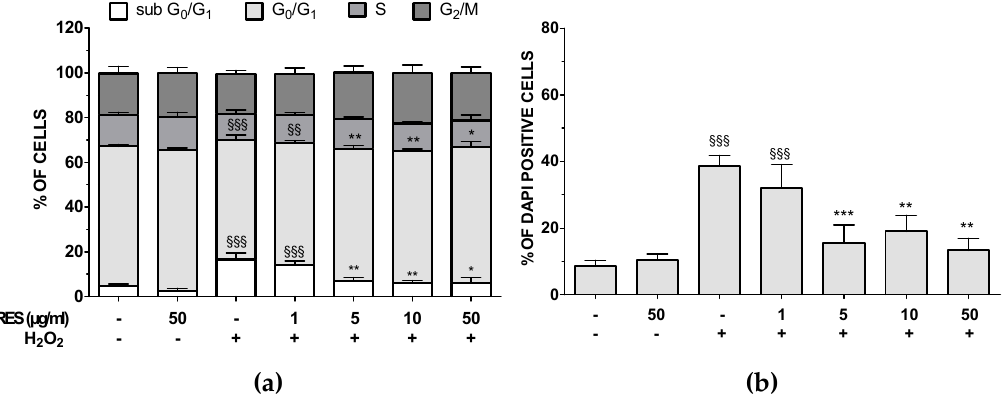
Figure 3. Effects of PRES on OS-induced changes in SH-SY5Y cell cycle and DNA condensation. Cells were treated with PRES (1–50 µg/mL) for 1 h before OS and for the following 24 h. OS was reproduced by using H 2 O 2 (25 µM for 1 h + 24 h with medium). ( a ): cell cycle analysis: percent of cells in the subG 0 /G 1 (apoptotic), G 0 /G 1 , S or G 2 /M phase determined by flow cytometry after propidium iodide staining. ( b ): apoptotic cells detected by DAPI staining: quantitative analysis. Data are reported as means ± SEMs. §§ p < 0.01, §§§ p < 0.001 vs. untreated cells; * p < 0.05, ** p < 0.01, *** p < 0.001 vs. H 2 O 2 (one-way ANOVA and Bonferroni